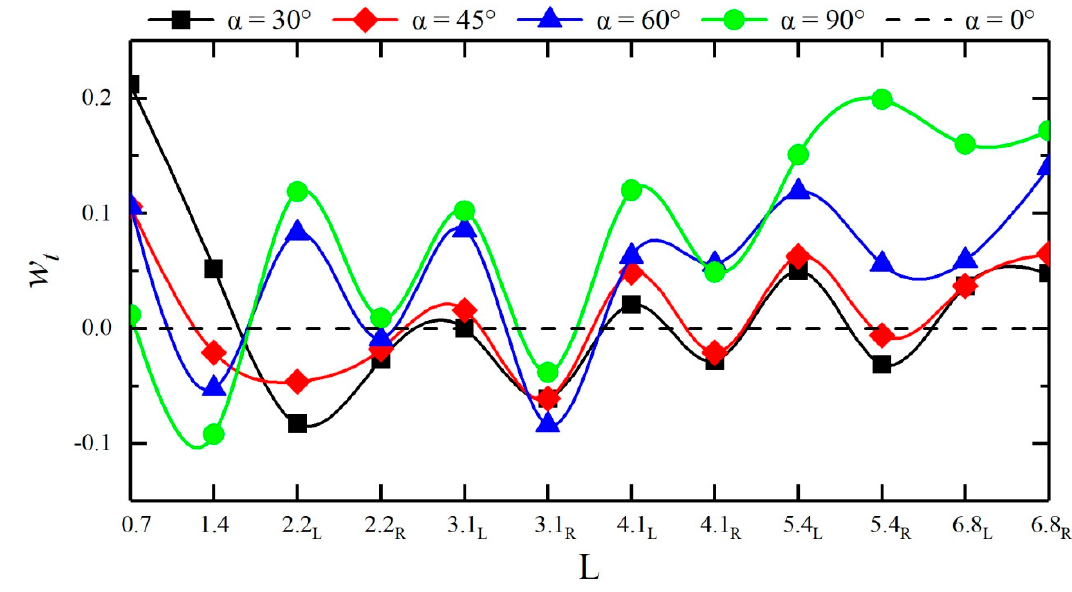
Figure12. Risetimeretardationfactors w t ateachmeasuringpointofdi ff Figure 12. Rise time retardation factors w t at each measuring point of different confluence configurations.